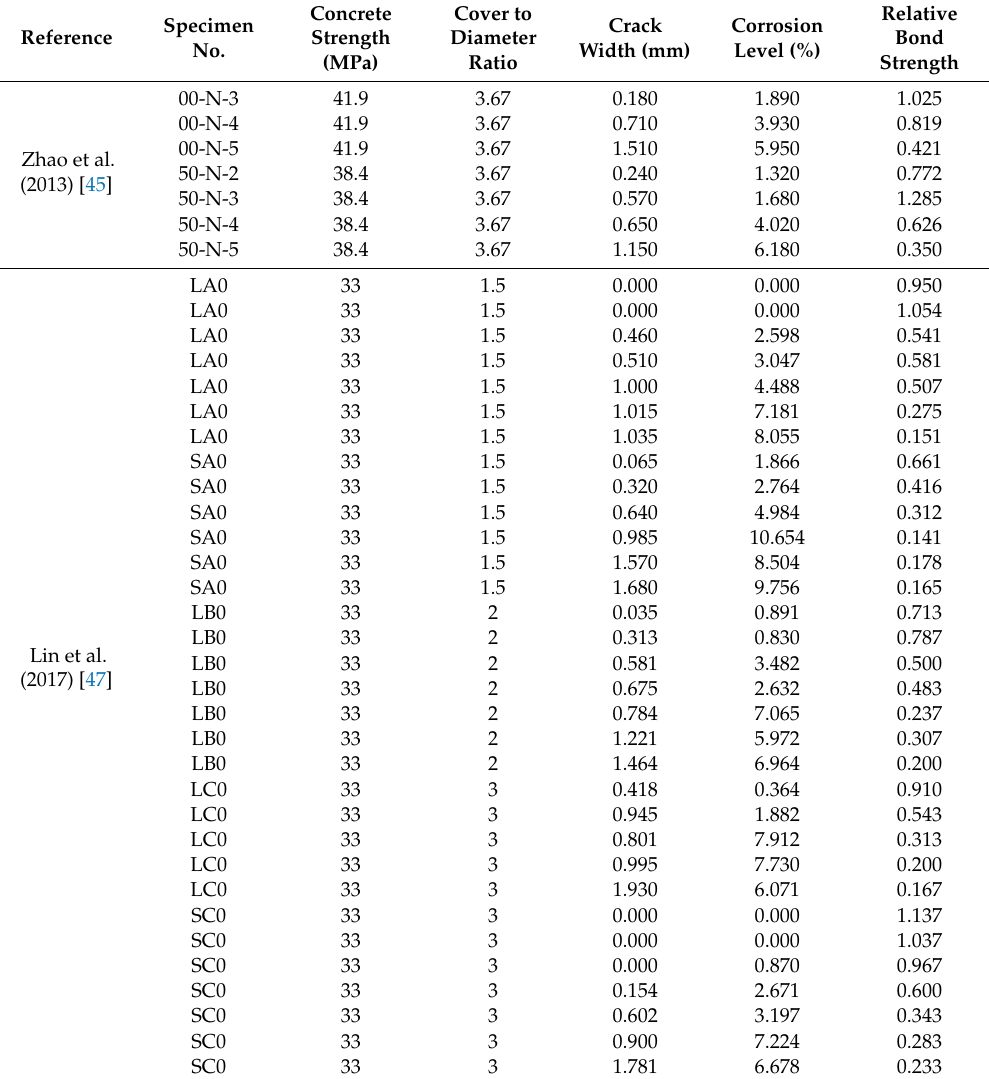
Table A3. Dataset for cases without stirrups and variables including corrosion level ( n =